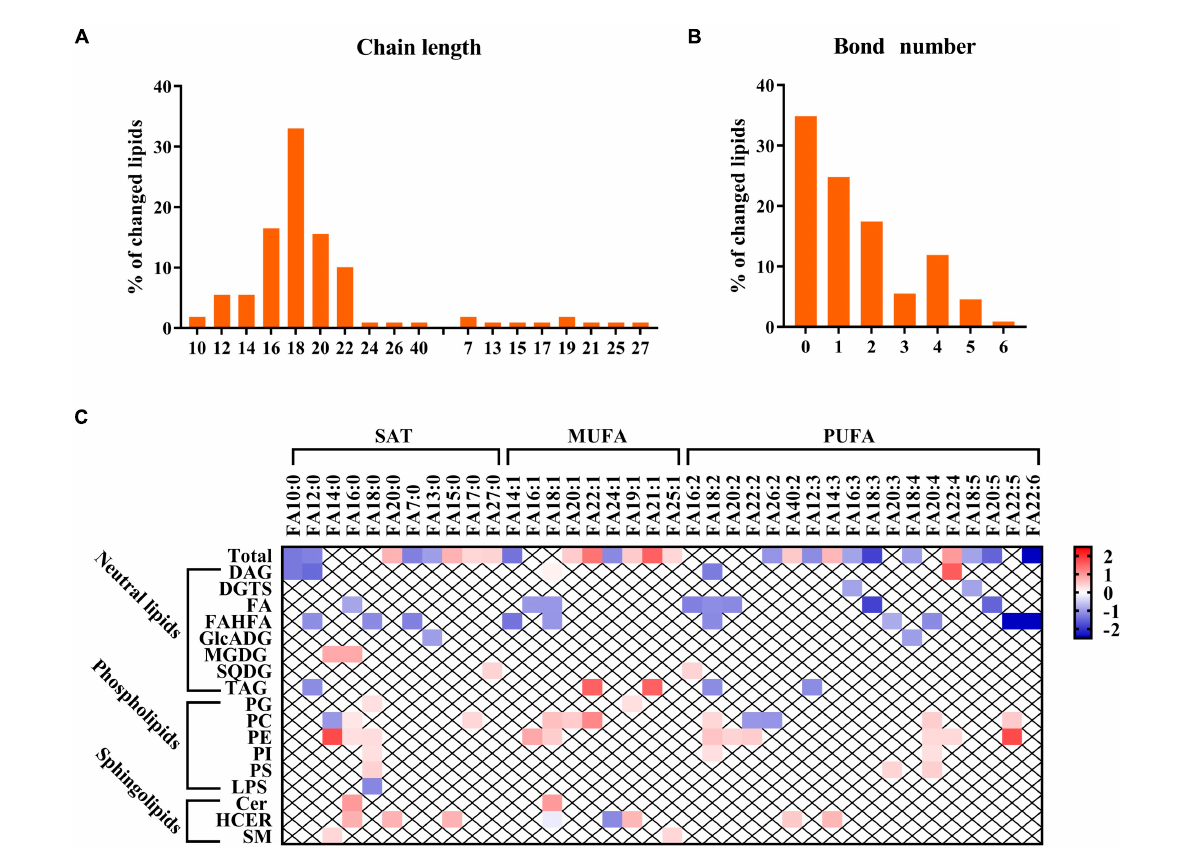
FIGURE4 Breast milk lipids structure analysis in relation to GDM. (A,B) Chain length and bond number of breast milk lipids in relation to GDM. (C) Relationship between GDM and fatty acid composition. Red and blue colors denote lipid structure changes between GDM and NC group.